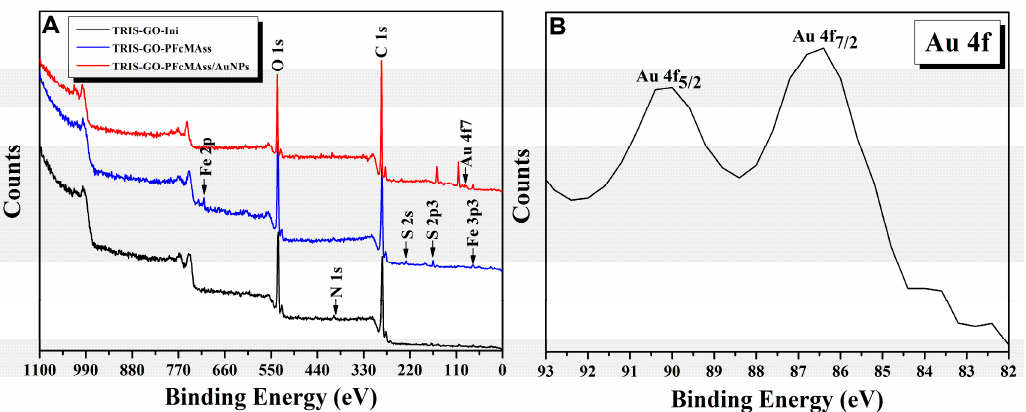
Figure 4. ( A ) XPS spectra of TRIS-GO-Ini, GO-PFcMAss and GO-PFcMAss/AuNPs. ( B ) XPS spectrum of Au4f in GO-PFcMAss-AuNPs.